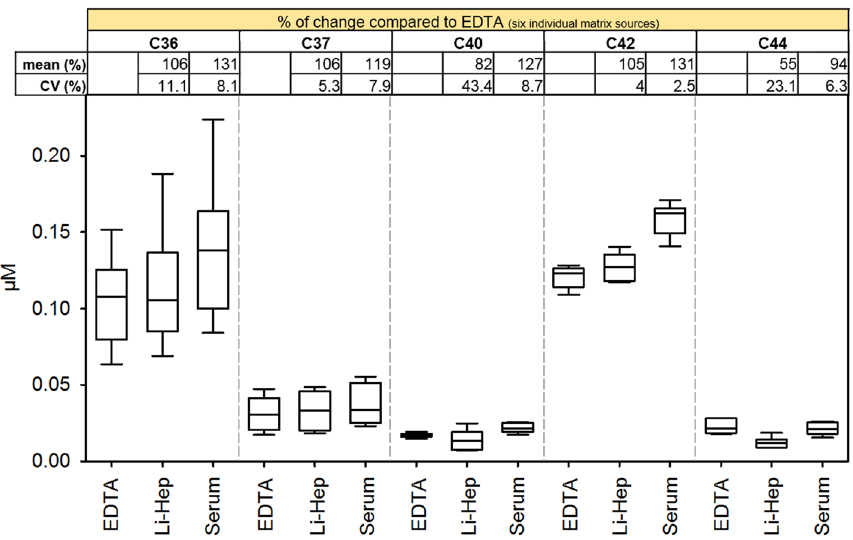
Figure 1. Comparison of CAAP levels in EDTA plasma, lithium-heparin plasma and serum. Relative changes (compared to EDTA plasma) were calculated for each donor individually (n = 6) before mean accuracy (%) and CV (%) were calculated.